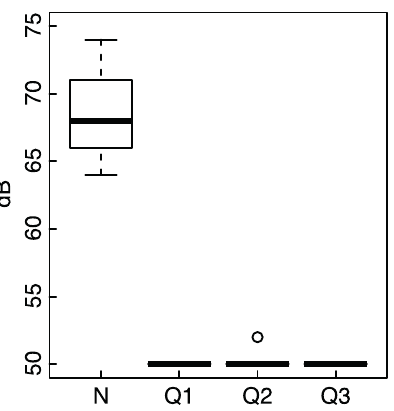
Figure 1. Mean noise levels at the four sites. Noise levels were assessed during the breeding season and measured at five random nestboxes at each site. We used a Silverline sound level meter, with A- weighting, with a range from 50–126 dB and an accuracy of 6 2